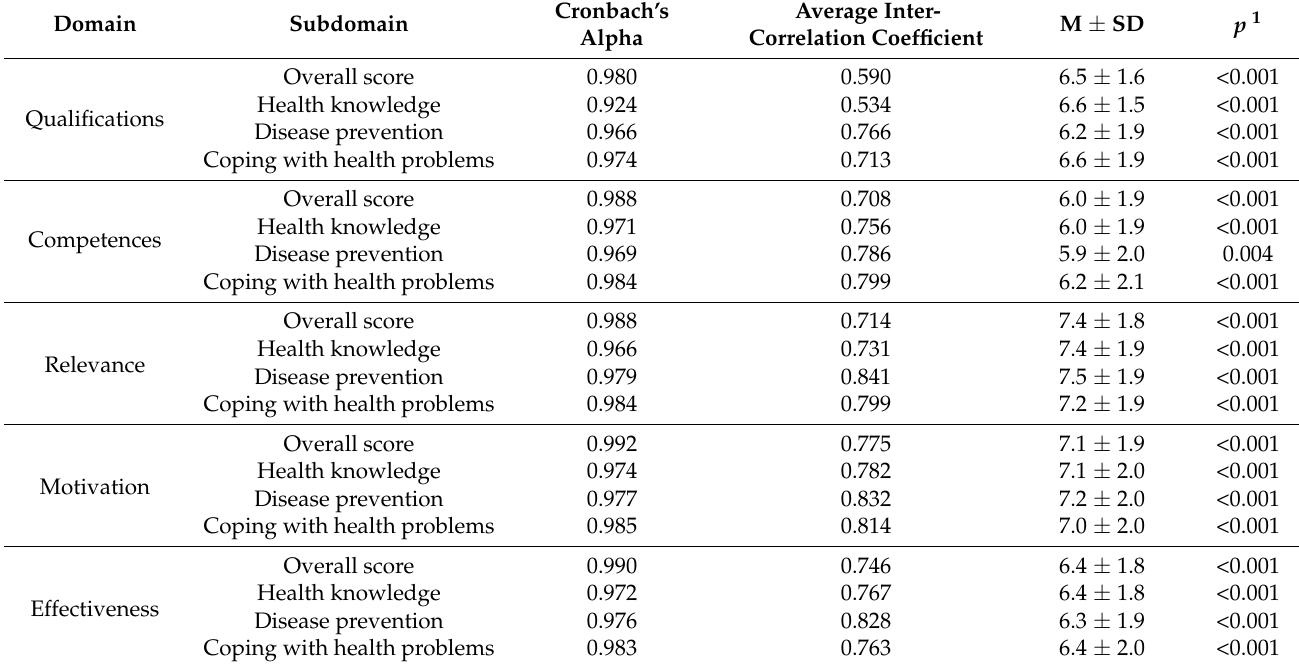
Table 5. Pharmacy students’ assessment of qualifications, competences, relevance, motivation and effectiveness in health promotion—domains and subdomains (N =